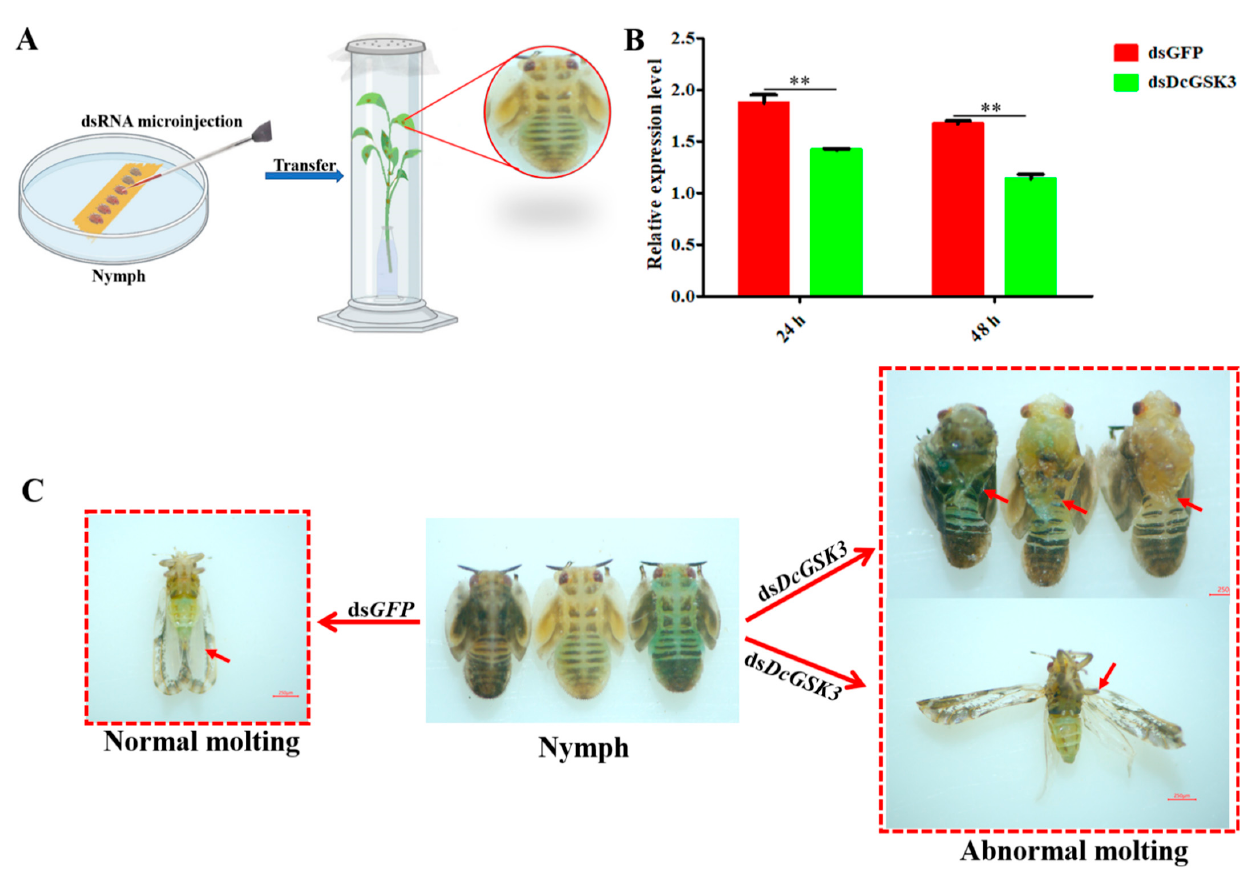
Figure 4. Detection of DcGSK3 expression levels and phenotypic observation after treatment with ds DcGSK3 and ds GFP . ( A ) Illustration of the protocol used for RNA interference. ( B ) Analysis of DcGSK3 expression levels after treatment with ds DcGSK3 and ds GFP . The asterisks indicate the significance differences by ** p < 0.01. ( C ) Phenotypic observation of D. citri adult at 48 h.